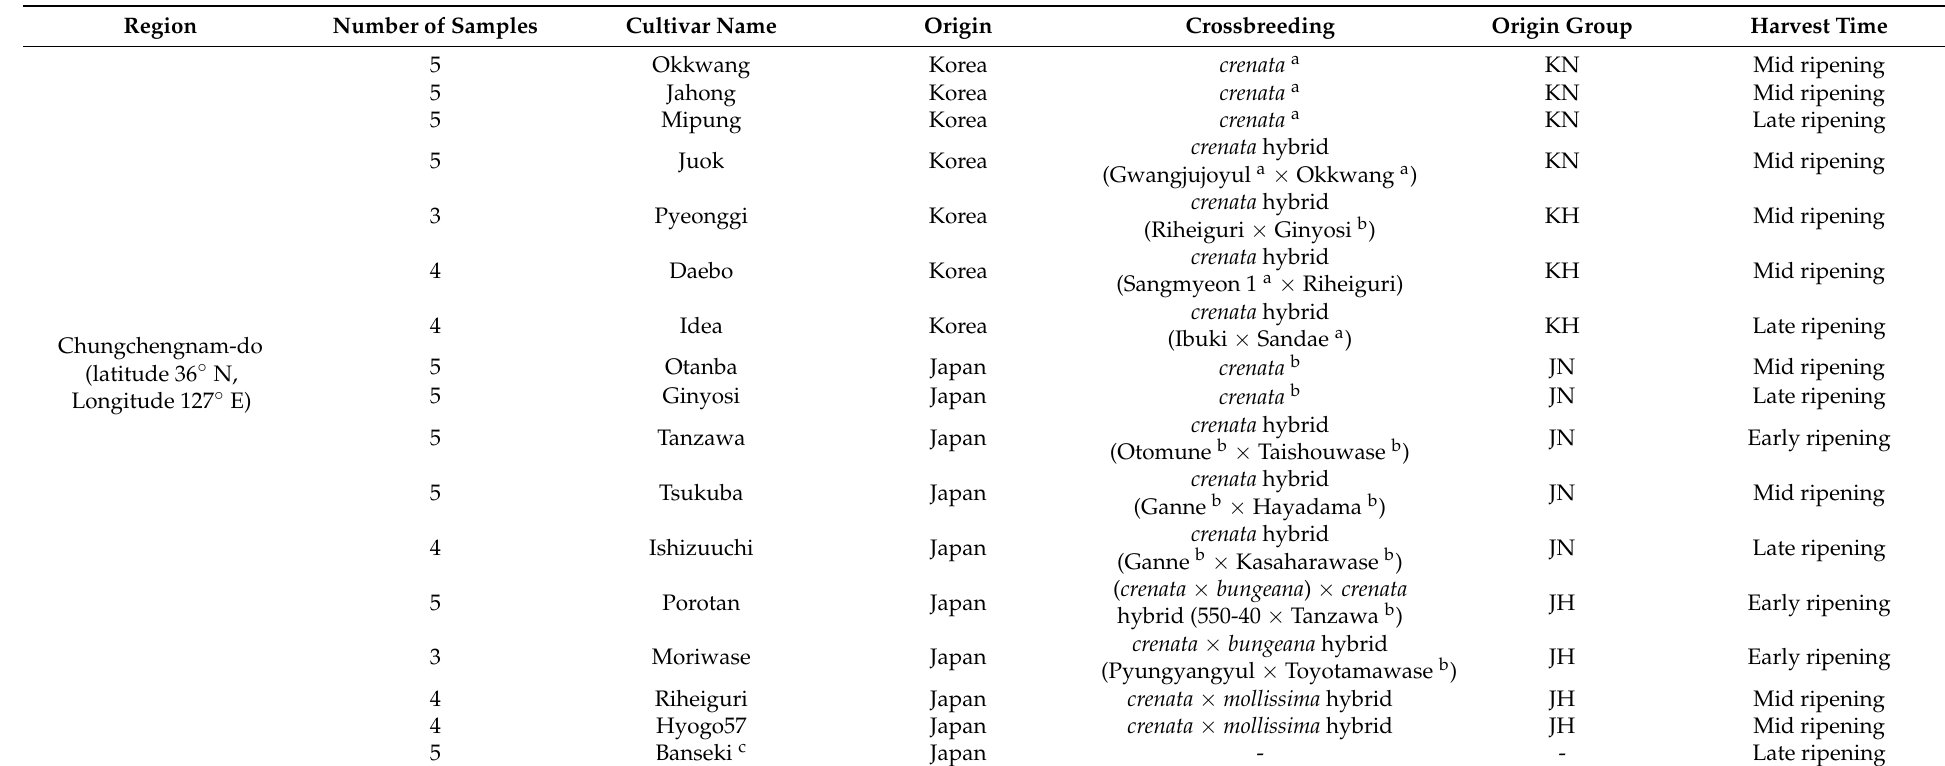
Table 1. Sample list of Castanea crenata chestnut used in this